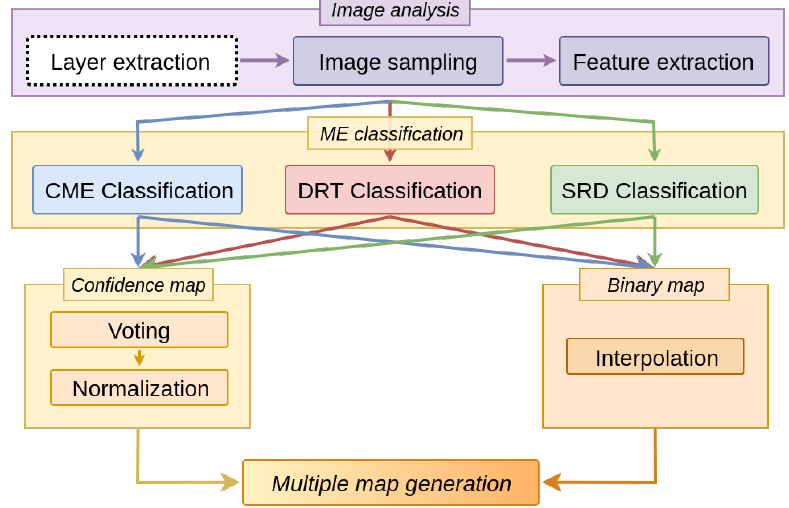
Figure 3. Steps to generate the proposed multiple map